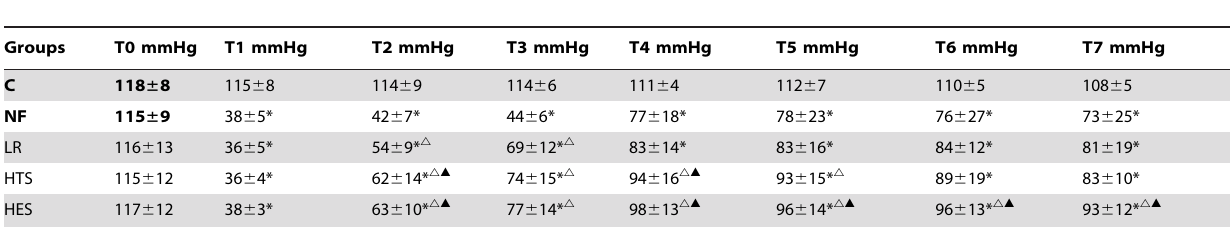
Table 1. The varieties of mean arterial pressure (MAP) at different time points in the rats (12 animals in each group).